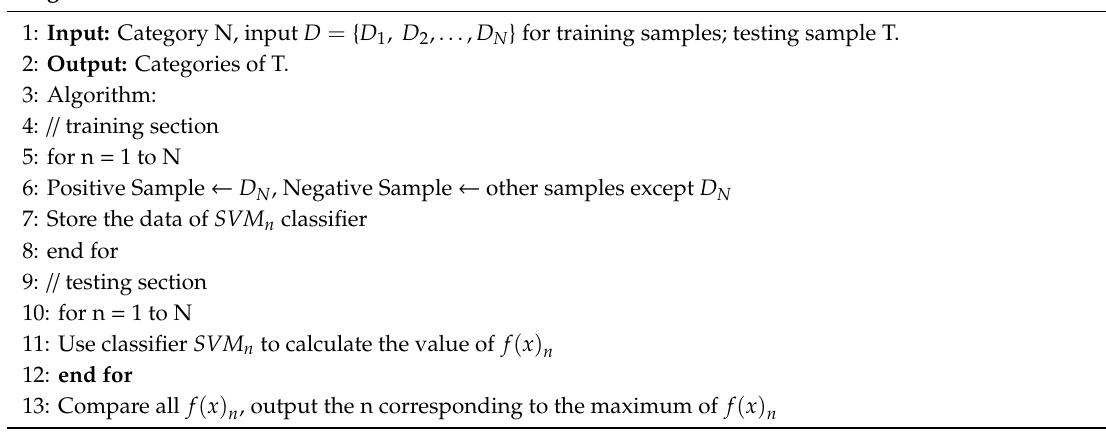
Algorithm 1 MCSVM